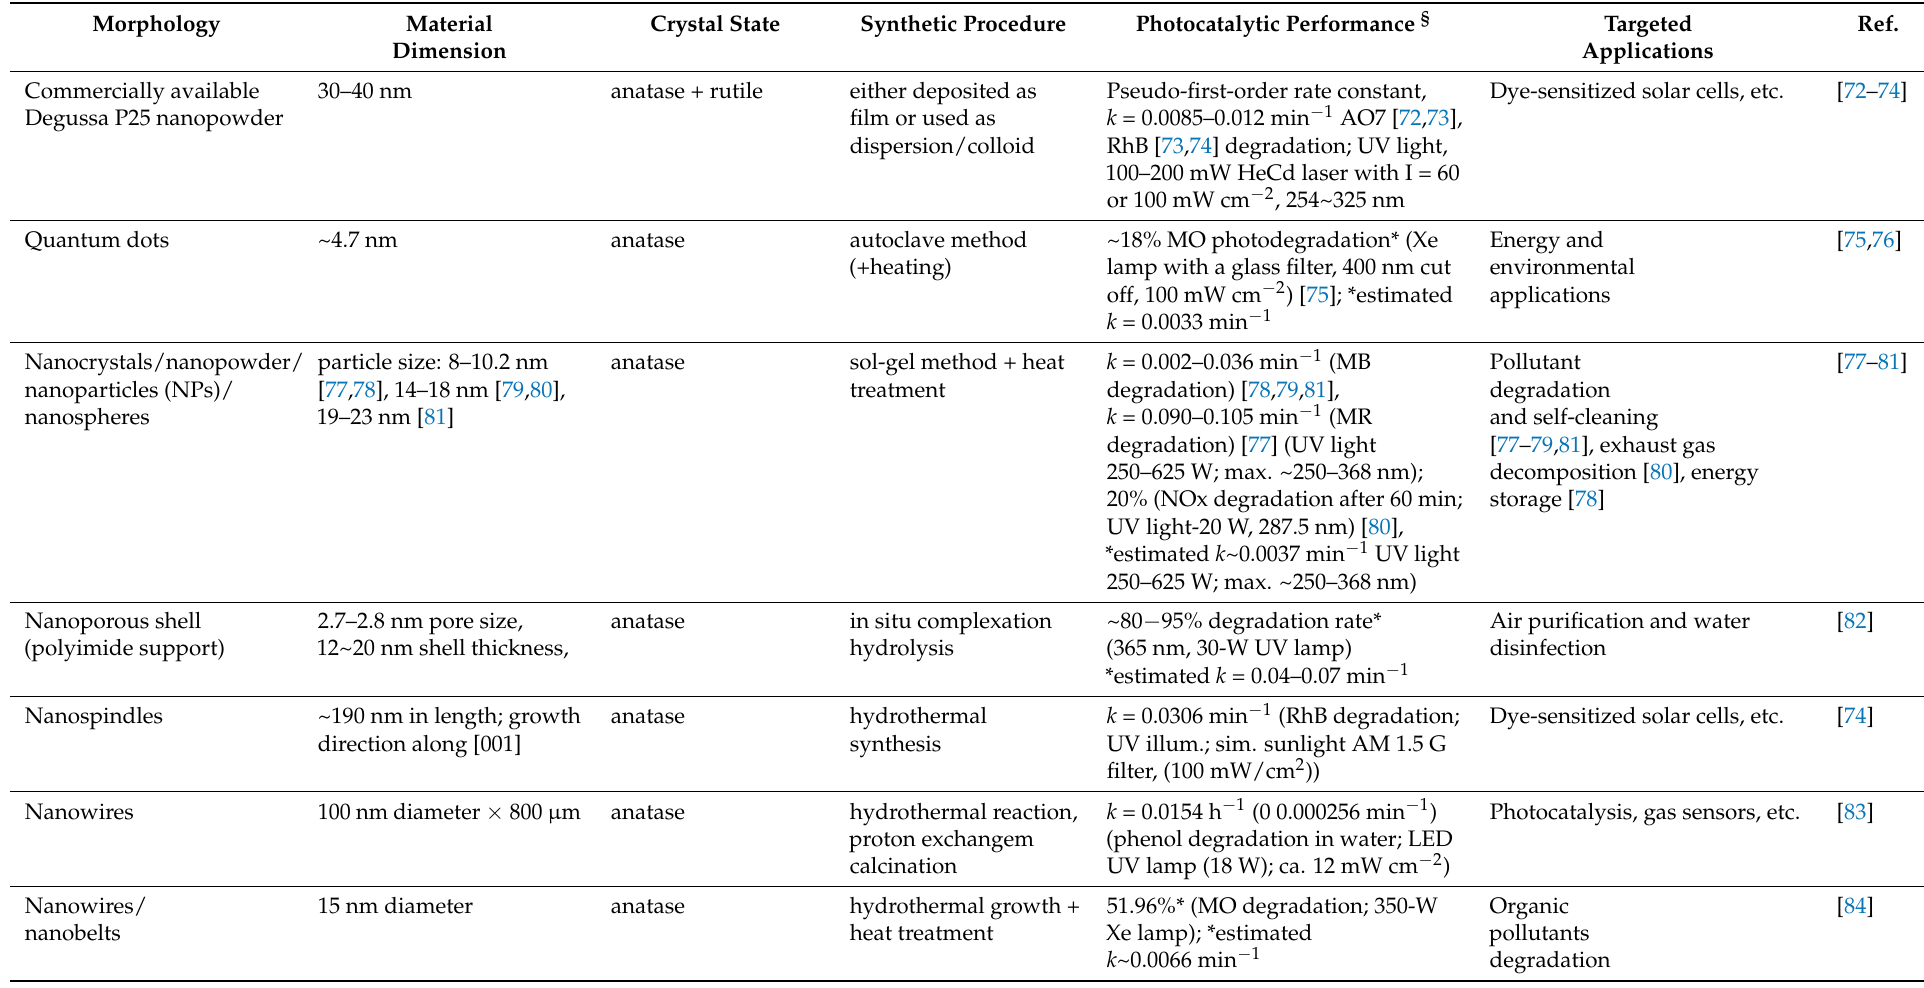
Table 1. Reported photocatalytic performance of some TiO 2